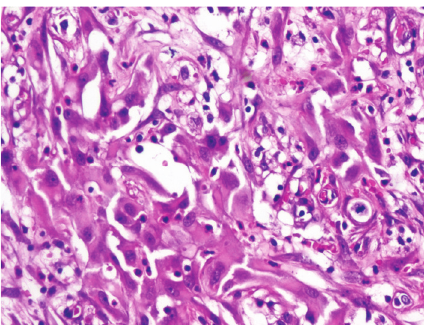
Figure 3: Epithelioid cells have large and big regular nuclei. See the presence of mitosis with no atypia.